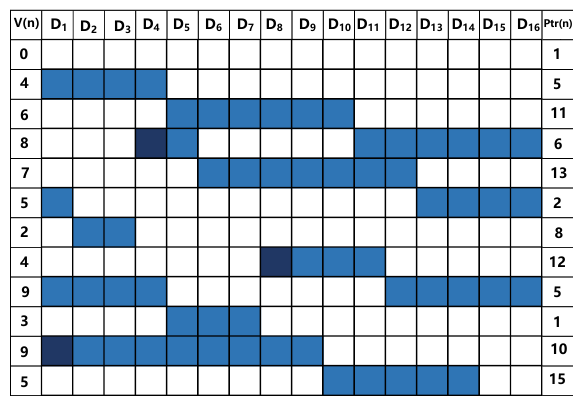
Figure 13. Demonstration of the RnDWA algorithm, the left-most (V(n)) column is the input data sequence, and the right-most (Ptr (n) ) column is the position of the